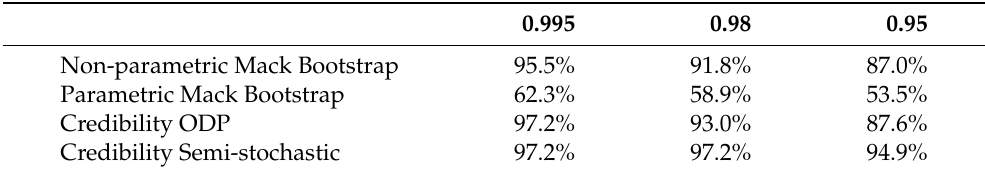
Table 1. The relation between the estimated VaR and how frequently that number exceeds the actual claim value observation.